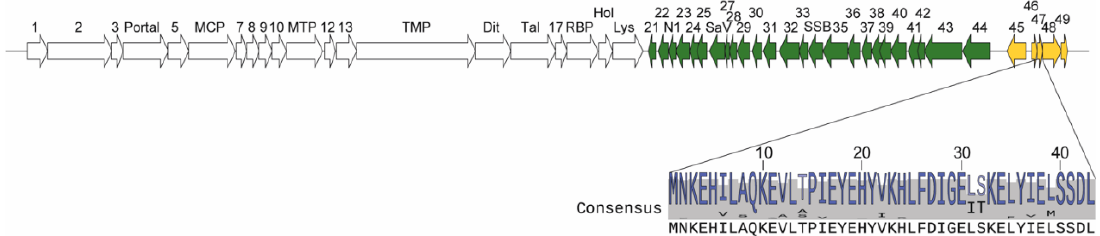
Figure 1. Phage p2 genome, orf47 location and ORF47 consensus sequence. The genes are represented by arrows and numbers. Early-expressed genes are in green, middle-expressed in yellow and late-expressed in white. The consensus amino acid sequence of ORF47 in 184 publicly available Skunavirus genomes is shown (see Figure S1 (Supplementary Materials) for alignment). MCP: Major capsid protein, MTP: Major tail protein, TMP: Tail tape measure protein, Dit: Distal tail protein, Tal: Tail associated lysin, RBP: Receptor binding protein, Hol: Holin, Lys: Lysin, SaV: Sensitivity to AbiV protein, SSB: Single stranded binding protein.